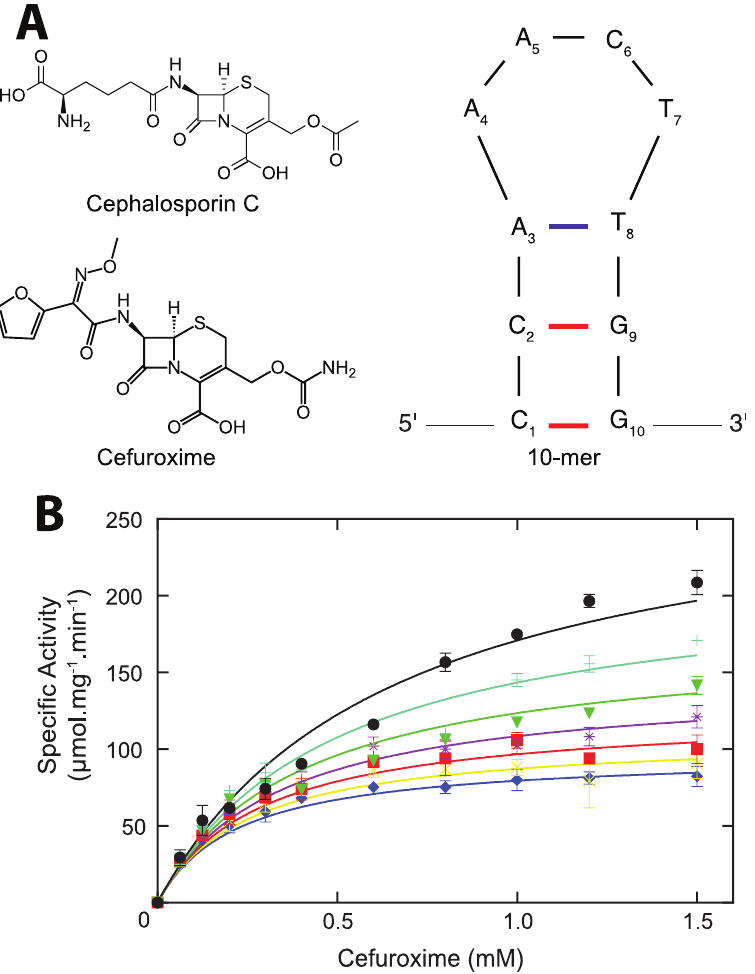
Fig 1. Inhibition of 5/B/6 MBL by the 10-mer aptamer during cefuroxime hydrolysis. A) Chemical structures of the β -lactam antibiotics cephalosporin C and cefuroxime. Also shown is the M-fold predicted secondary structure of the 10-mer DNA aptamer. B) Plot of the specific activity versus cefuroxime concentration. Points and error bars are the average and standard deviation of at least three measurements. Solid lines represent the non-linear regression calculation (global correlation coefficient R 2 = 0.964), which shows the uncompetitive inhibition pattern during cefuroxime hydrolysis. Black circle: 10-mer concentration [I] = 0 (local correlation coefficient R 2 = 0.969); cyan: [I] = 20 nM (R 2 = 0.957); green: [I] = 40 nM (R 2 = 0.961); magenta: [I] = 60 nM (R 2 = 0.965); red: [I] = 80 nM (R 2 = 0.949); yellow: [I] = 100 nM (R 2 = 0.913); and blue: [I] = 120 nM (R 2 =